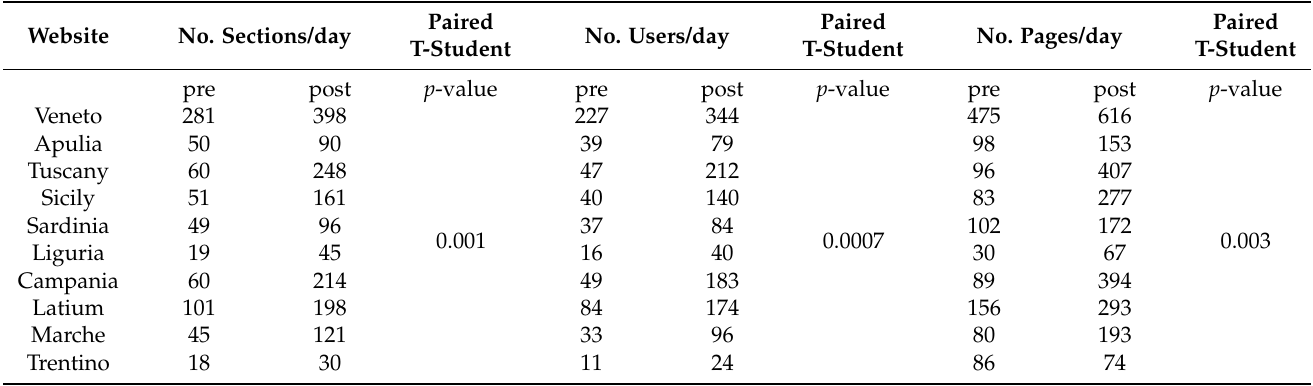
Table 3. VaccinarSì Network. Statistical differences in the number of sections, users and pages per day during the pre-COVID-19 and COVID-19 eras.